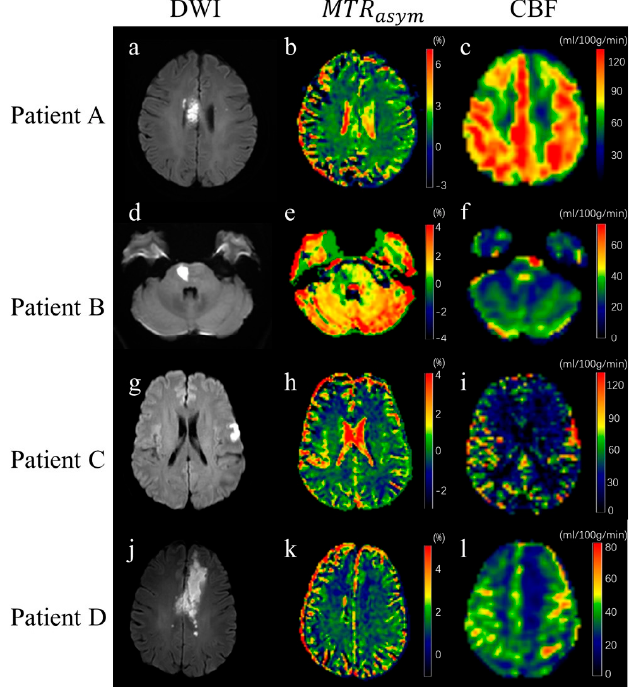
Figure 2. Rows 1–4 show an illustration of MR images of four patients. Columns 1–3 contain DWI images, MTR asym maps, and CBF maps,